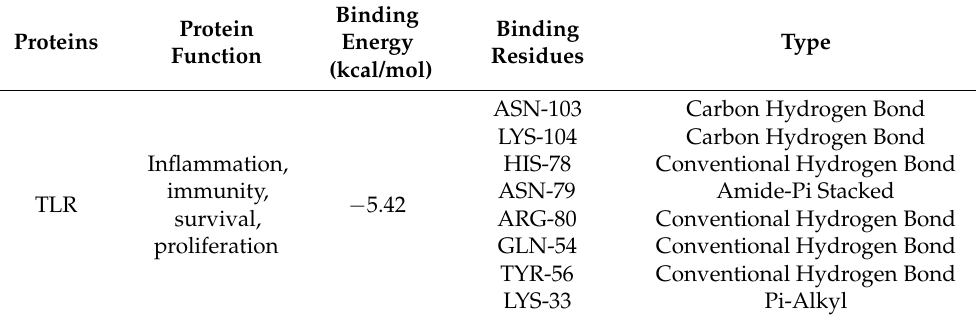
Figure 7. Molecular docking analyses of the putative binding between 11-O-(4’-O-methylgalloyl)- bergenin and TLR, NF- κ B, TNF, TNFR1A, and iNOS. ( A – E ) correspond to the binding models for interactions between 11-O-(4’-O-methylgalloyl)-bergenin and TLR, NF- κ B, TNF, TNFR1A, and iNOS, respectively. Hydrophobic or H-bond interactions are displayed as a colored surface. Table 3. Intermolecular interactions between Fr11 and TLR, NF- κ B, TNF, TNFR1A, and iNOS.